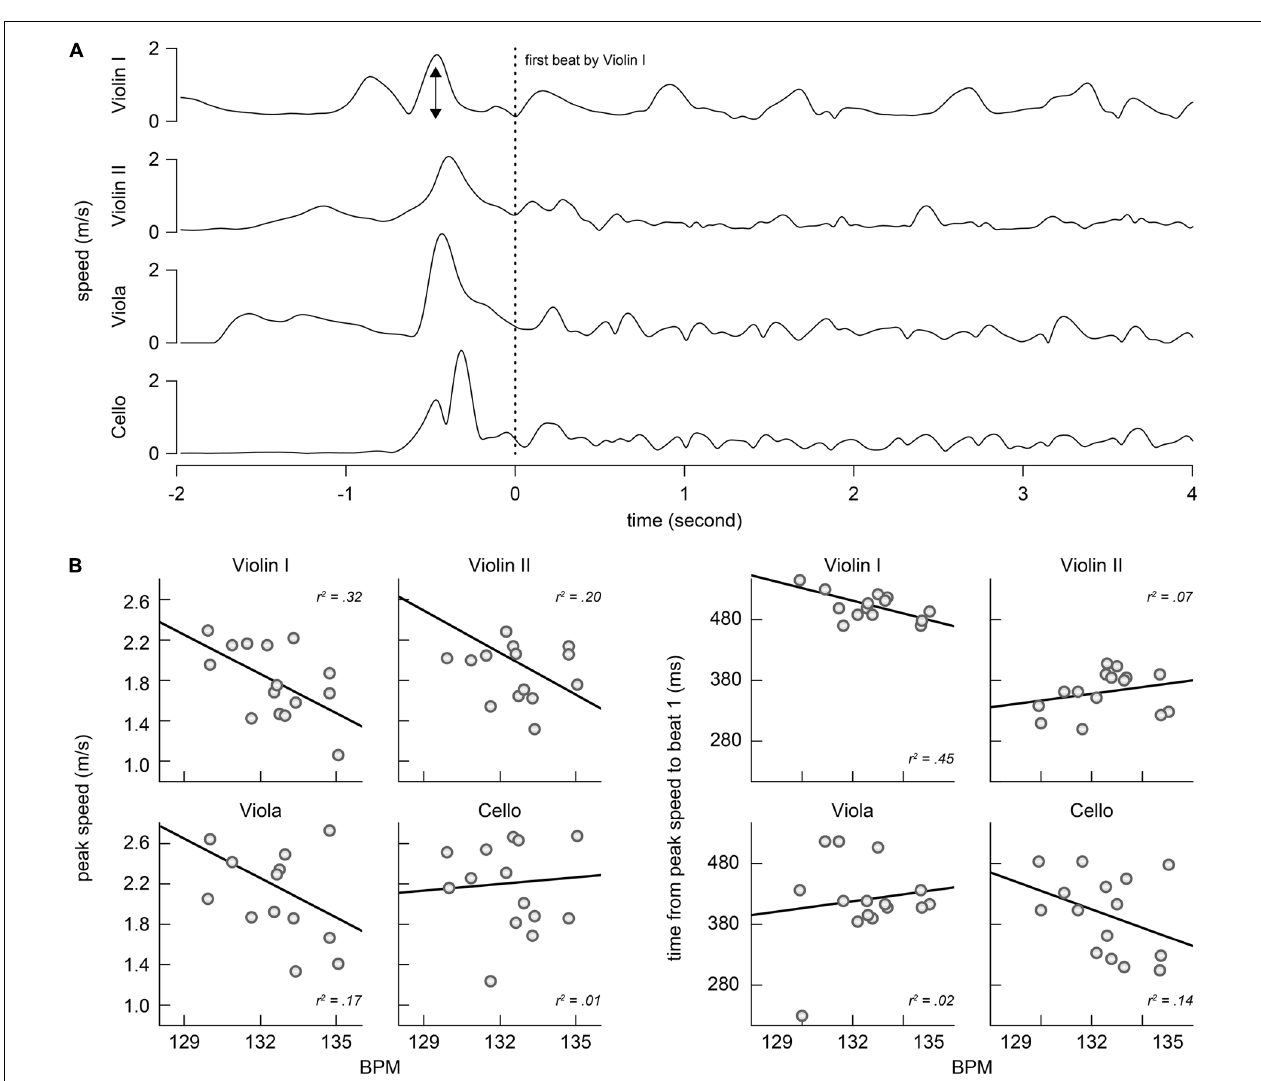
FIGURE 6 | (A) Bow speed around the time of the first tone and (B) correlations between the overall tempo of the music (beat per minute) and peak profiles (peak speed and the time between the peak speed and the first tone onset).